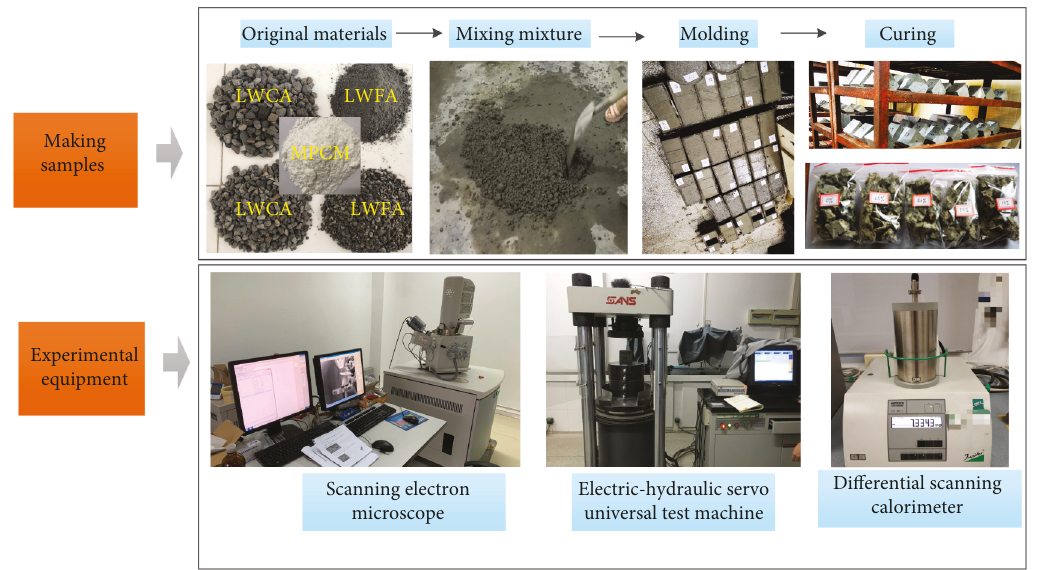
Figure 3: Specimen making and experimental